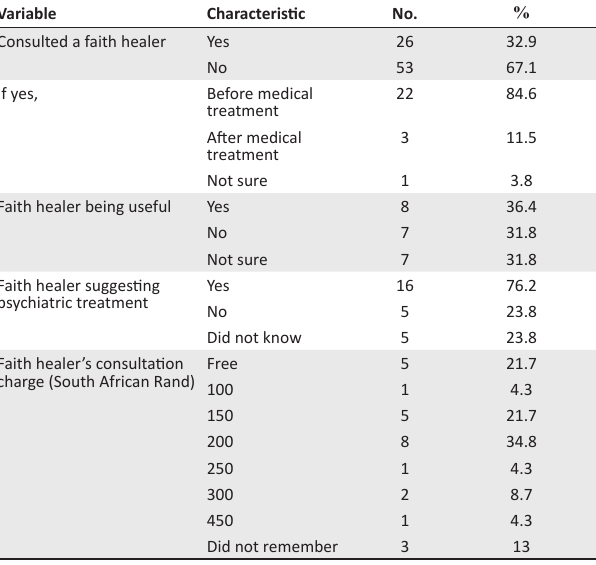
TABLE 2: Consultation with a faith healer ( n = 26 of the 79 parents). TABLE 1: Parents’ socio-demographic characteristics ( n =